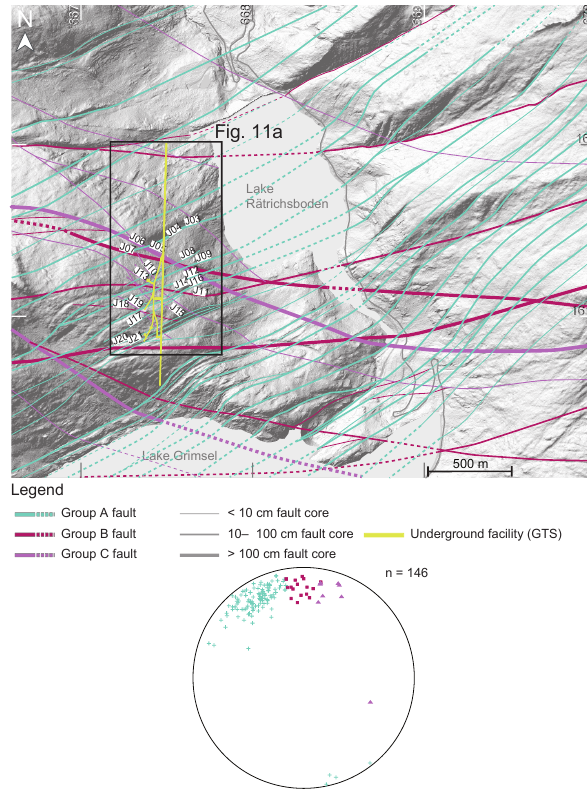
Figure 7. Surface fault map with faults grouped by strike orien- tation (group A, B, C). Hillshade image underlying the map is based on swissALTI3D (reproduced by permission from swisstopo; BA17063). Fault exposure lines are dashed over uncertain areas and labelled in cases for which a connection to GTS exists. Lower hemi- sphere equal area projection with plane poles grouped according to strike. The map is based on the Swiss coordinate system.